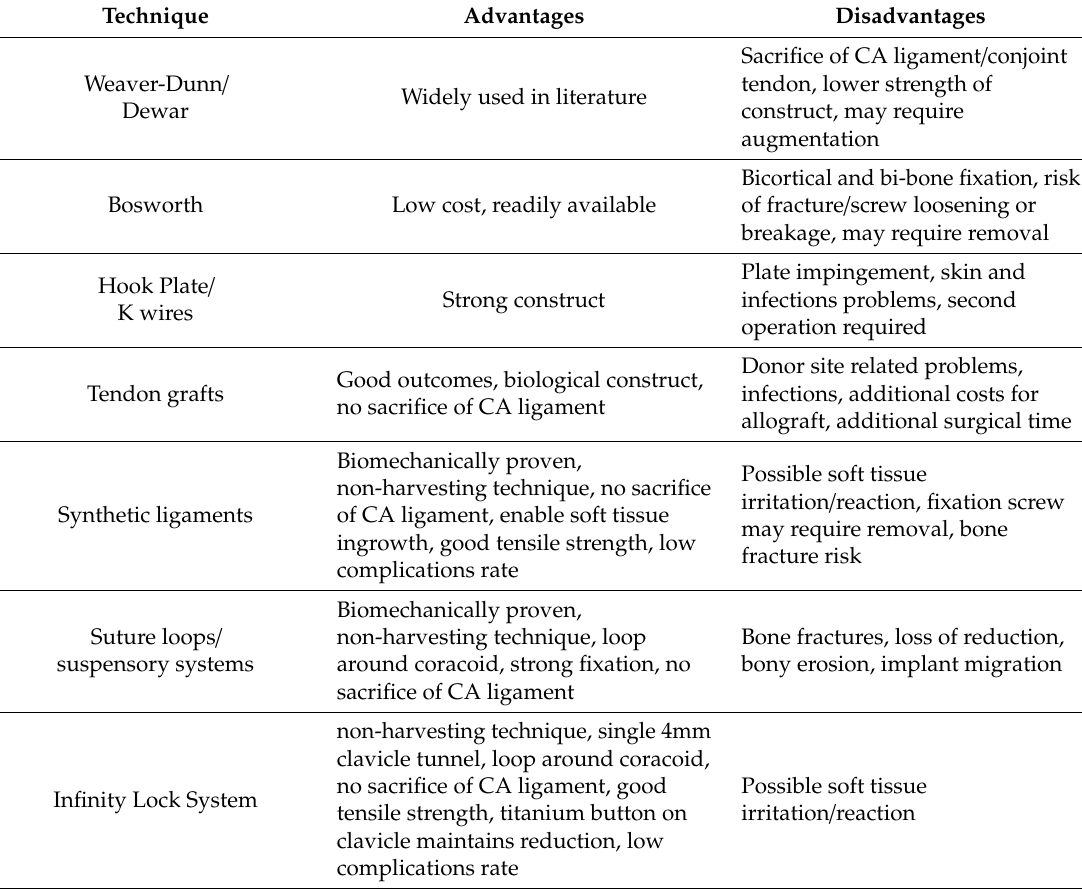
Table 1. Main Techniques employed in acromioclavicular (AC)